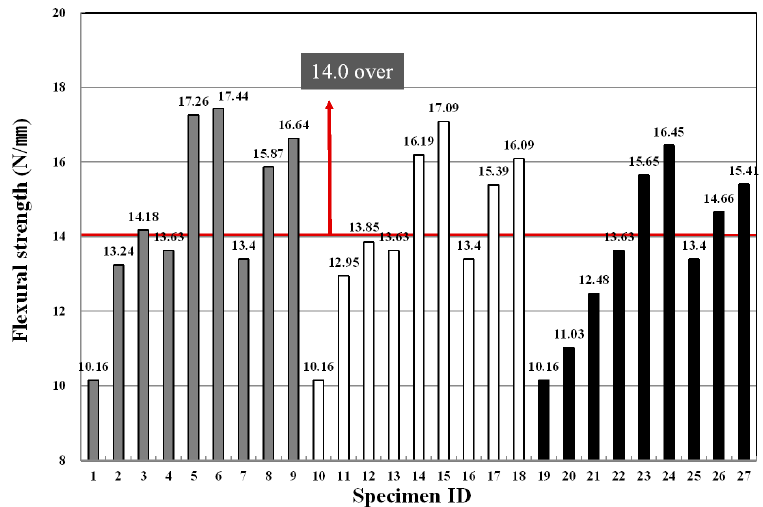
Figure 11. Variation of flexural strength for each specimen.